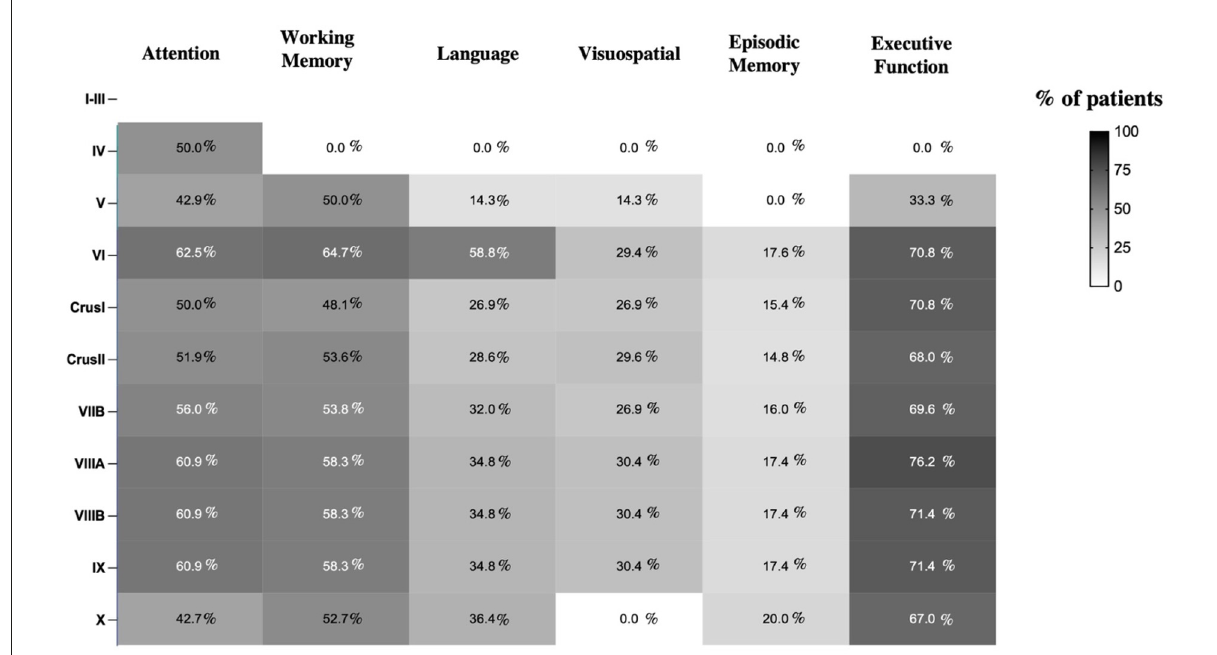
FIGURE5 Hot spot figure of the percentage of patients who were impaired in each cognitive domain, grouped according to lobular lesion topography. Description: Impaired cognitive domain was defined as z -score ≥ one standard deviation below healthy group means. The gray scale indicates the percentage of patients with impaired cognitive performance whose lesions involved a given lobule.